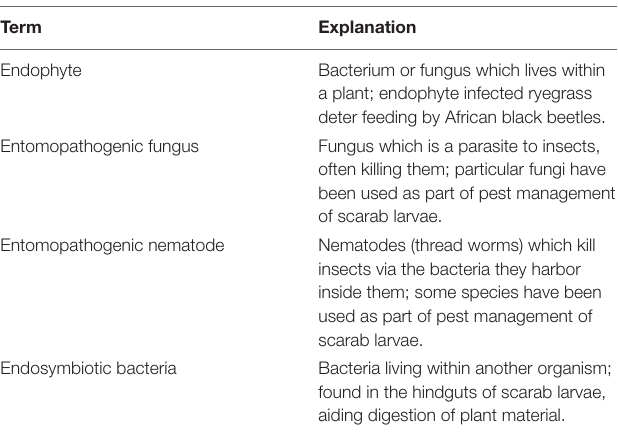
TABLE 1 | Glossary of